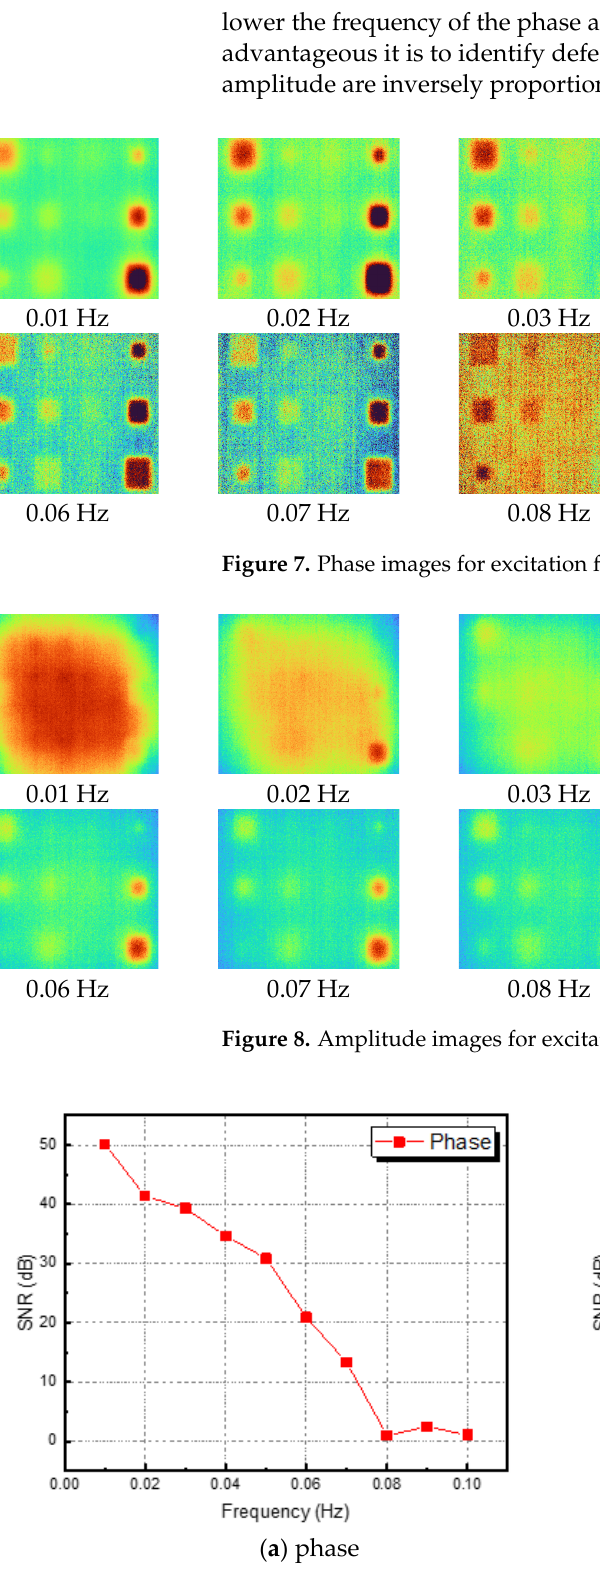
specimen with thinning defects.